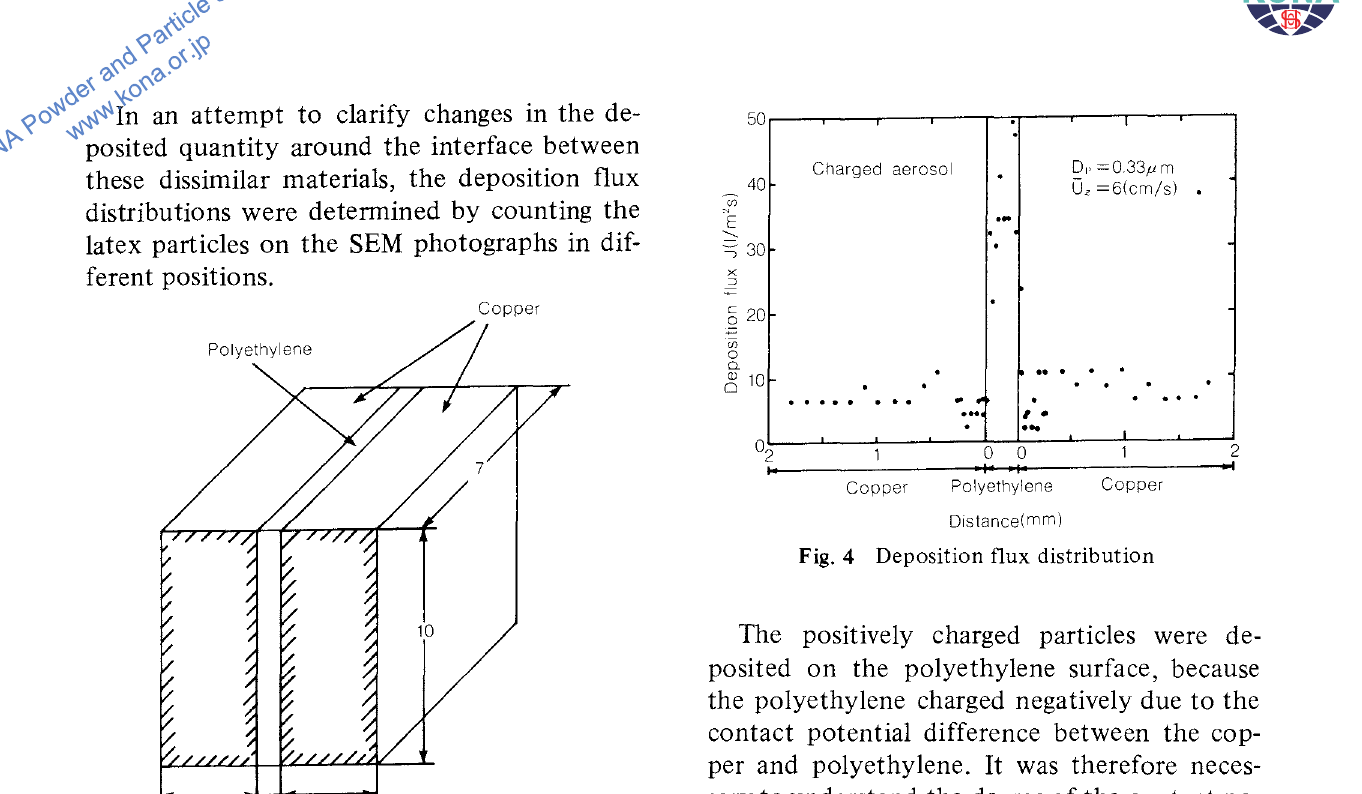
Fig. 2 Test piece composed of different materials